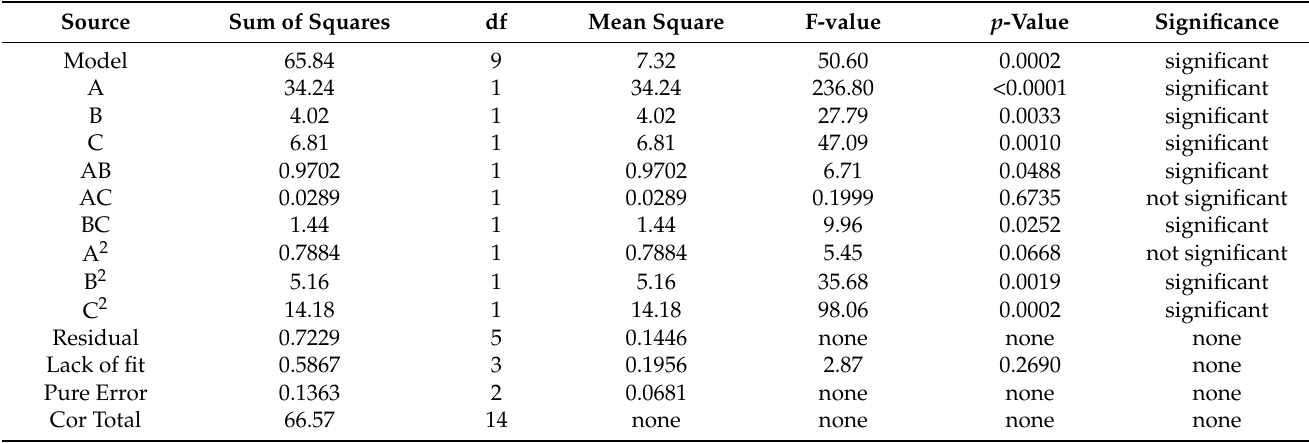
Table 4. Analysis of variance (ANOVA) for quadratic